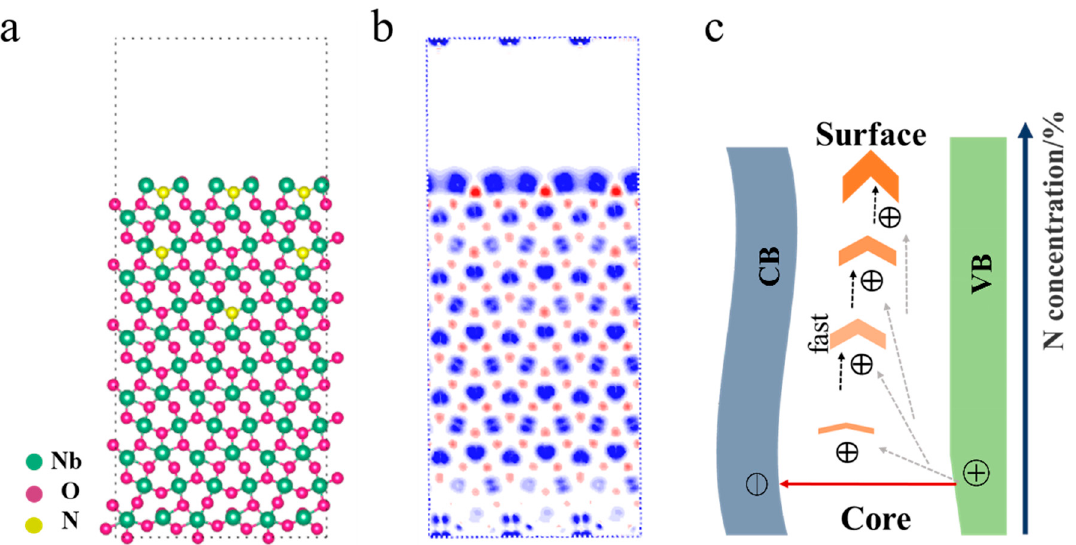
Figure 5. ( a ) Simulated geometric structures and ( b ) electron density of 001 plane of N-Nb 2 O 5 ; ( c ) Schematic diagram of photoexcited hole migration in N-Nb 2 O 5 under light irradiation. Green, purple and yellow spheres represent Nb, O and N elements, respectively, and blue represents the electron missing region; red represents the electron rich region. The direction of the arrow indicates from bulk to the surface of the catalyst.